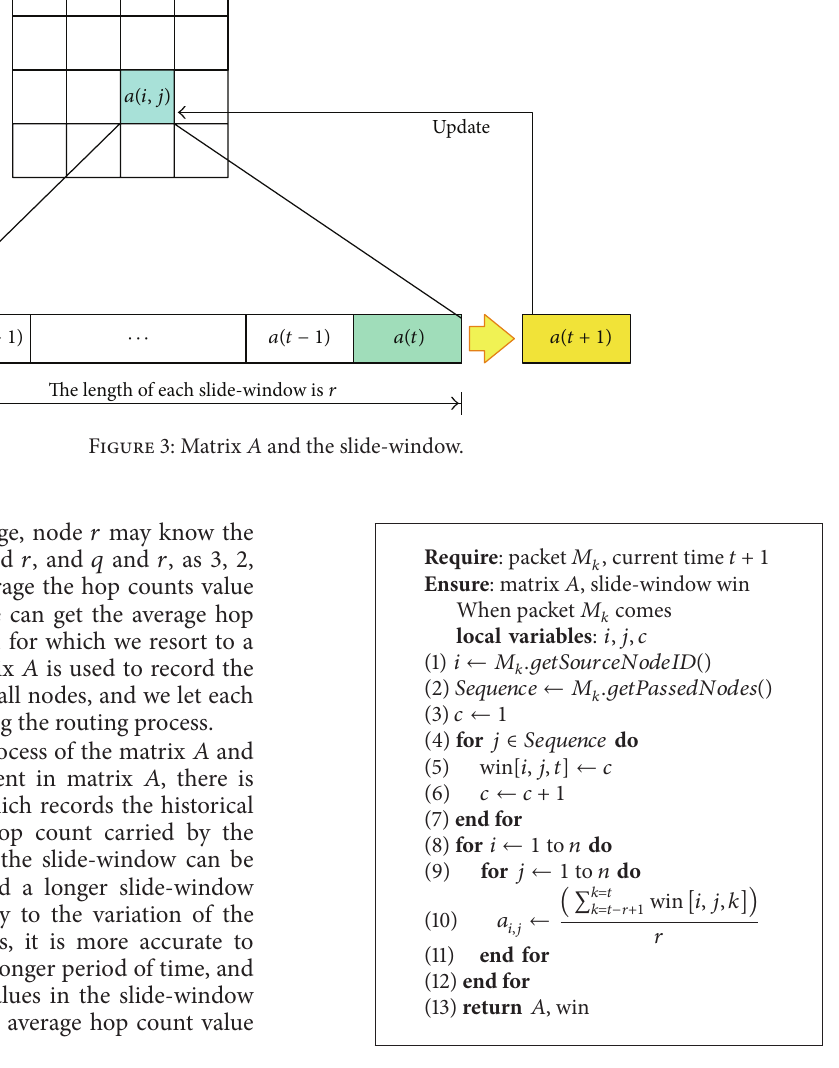
Algorithm 1: Maintaining the matrix 𝐴 and its